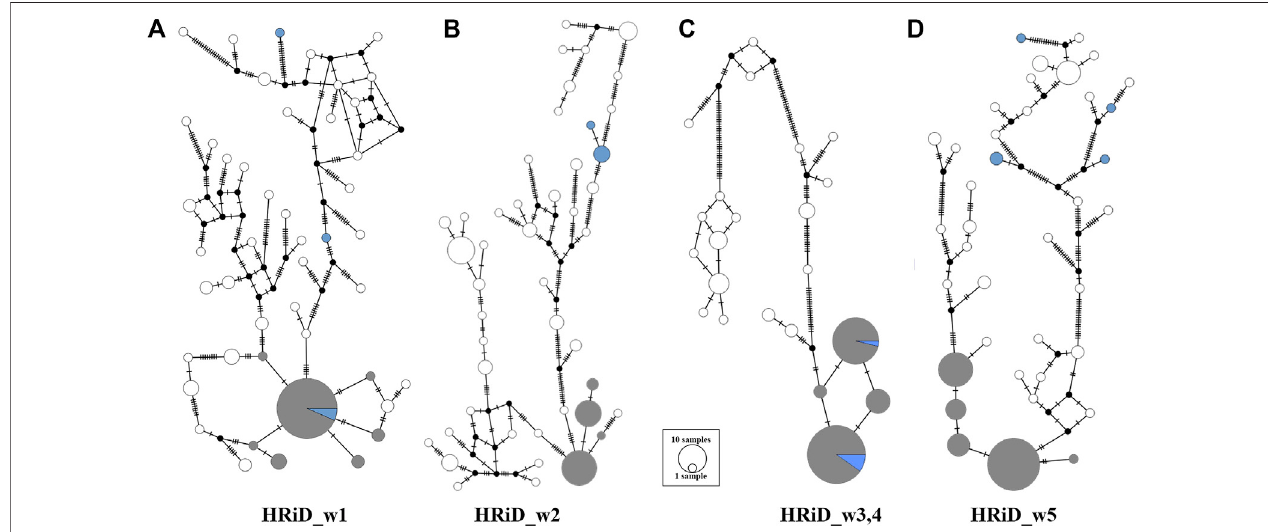
FIGURE 3 | Median-joining network showing the phylogenetic relationship between ancestral and derived haplotypes representing mapped selection signals identi fi edbyHRiD; (A) HRiD_w1(70SNPsfrom13.04to13.62 Mb), (B) HRiD_w2(70SNPsfrom115.30to115.73), (C) HRiD_w3andHRiD_w4(105SNPsfrom73.57 to 74.54), and (D) HRiD_w5 (70 SNPs from 56.64 to 58.09). The most common haplotypes with adjacent haplotypes no more than three mutations apart are coloured grey, whereas the mou fl on haplotypes (representing ancestral haplotypes) are coloured light